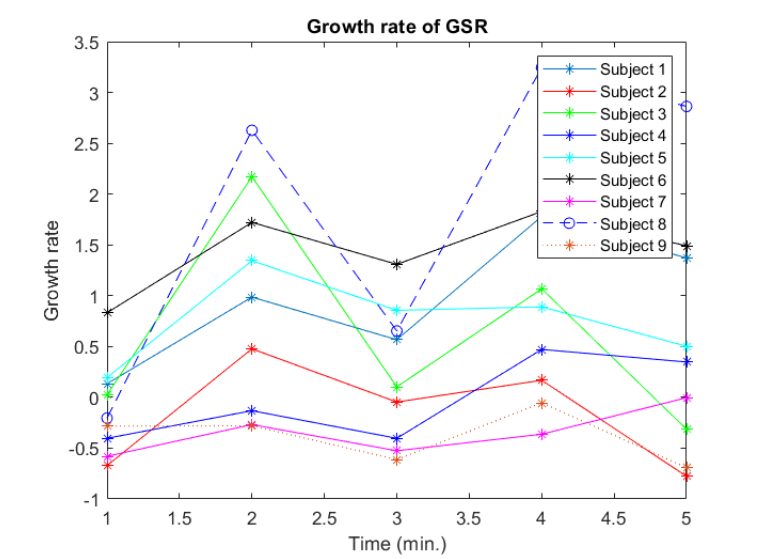
Figure 11. Experiment 3 growth rate of